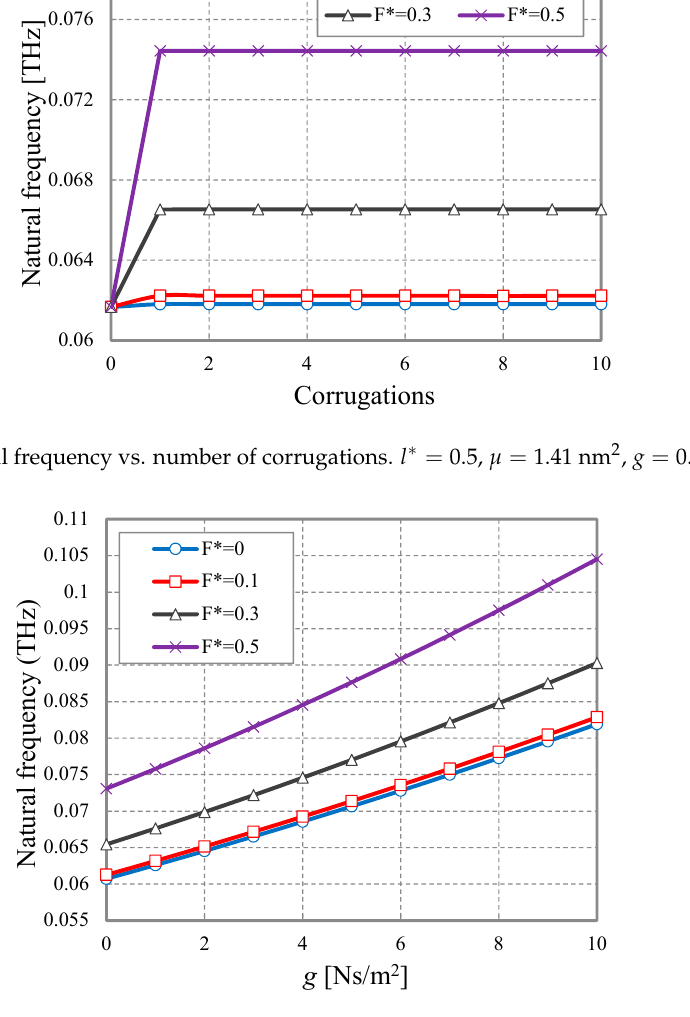
Figure 4. Natural frequency vs. viscoelastic damping. l ∗ = 0.5, µ = 1.41 nm 2 , c = 0.25 L x